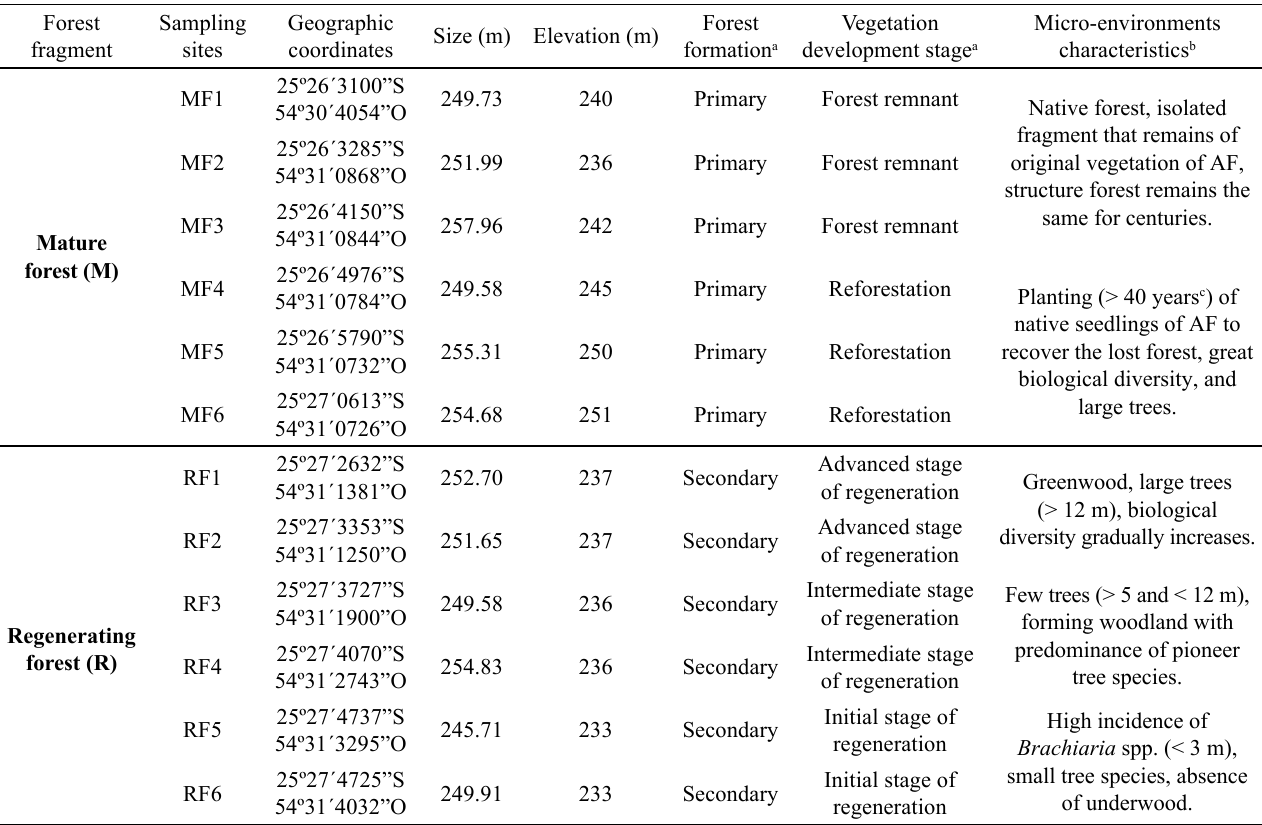
Table 1 . Environmental gradients: sampling sites, geographic coordinates, size (m), mean elevation (m), forest stage and sampling sites characteristics in the mature and regenerating forest fragment of the Atlantic Forest, Paraná, southern